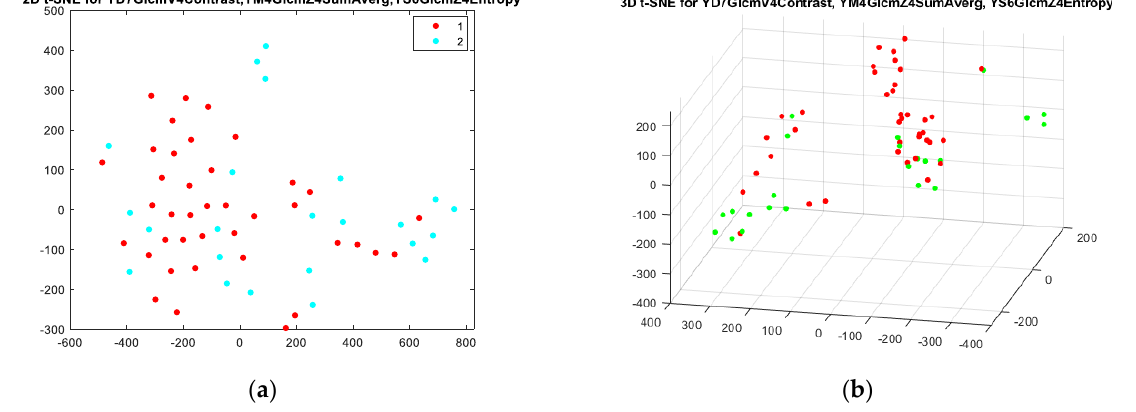
Figure 4. Two-dimensional t-SNE ( a ) and 3D t-SNE ( b ) for model IV for perplexity = 20. In ( a ), class 1 (red dots) represents cysts, and class 2 (blue dots) represents granulomas. In ( b ), red dots represent cysts, and green dots represent granulomas. In both figures, the red dots tended to accumulate in a particular area of space.